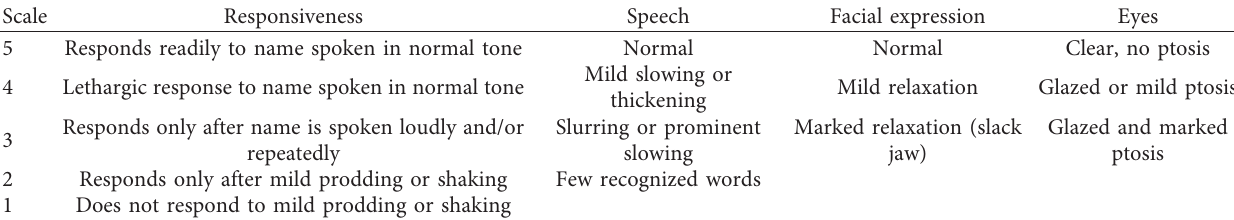
Table 1: Observer’s assessment of alertness/sedation (OAA/S)